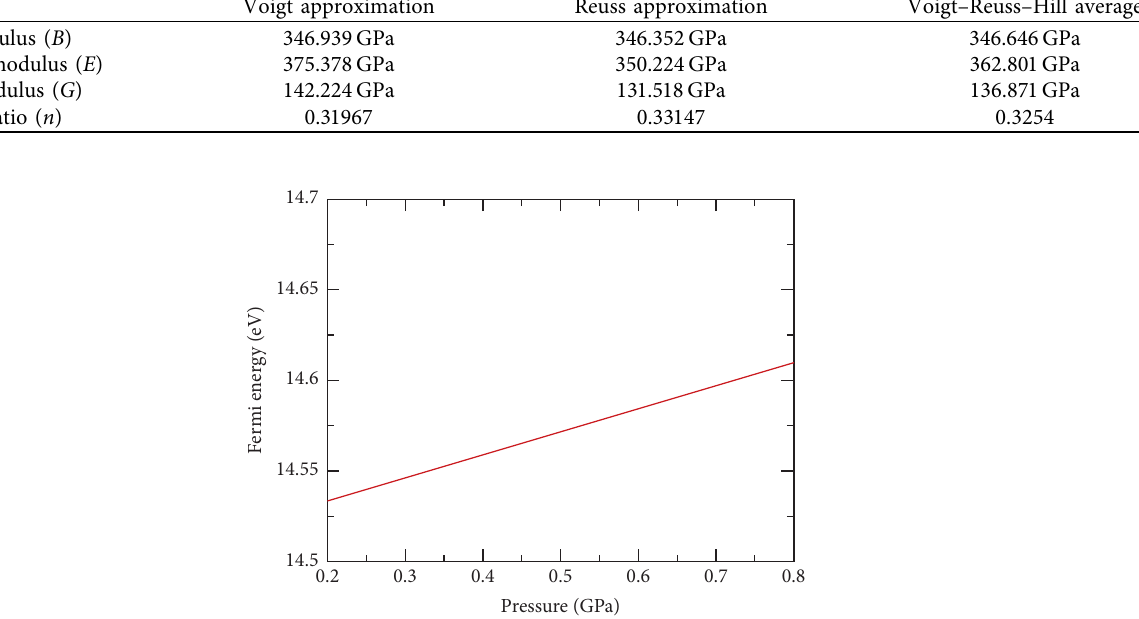
Figure 2: A graph of pressure against the Fermi energy from 0.2–0.8GPa. The Fermi energy increases with an increase in pressure up to 0.8GPa.